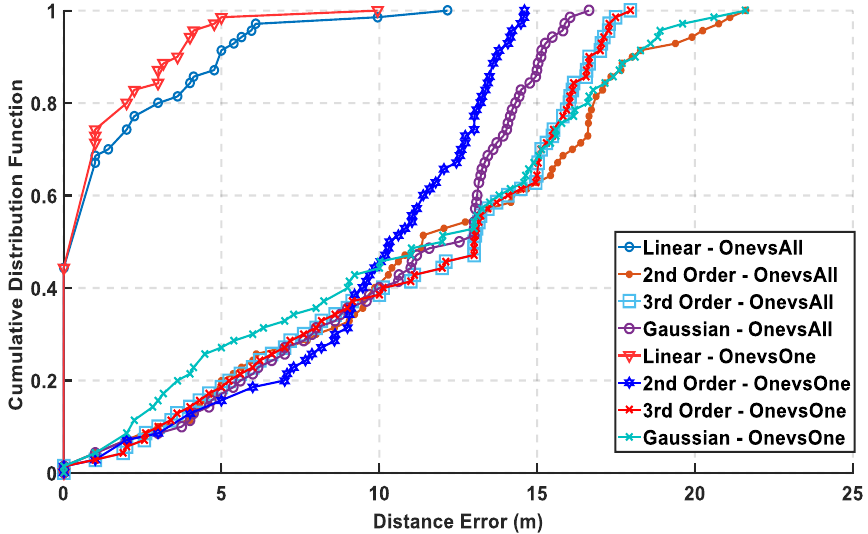
Figure 6. Mean Error is Calculated Relative to the Number of k Neighbors using the 18th Principal Component.